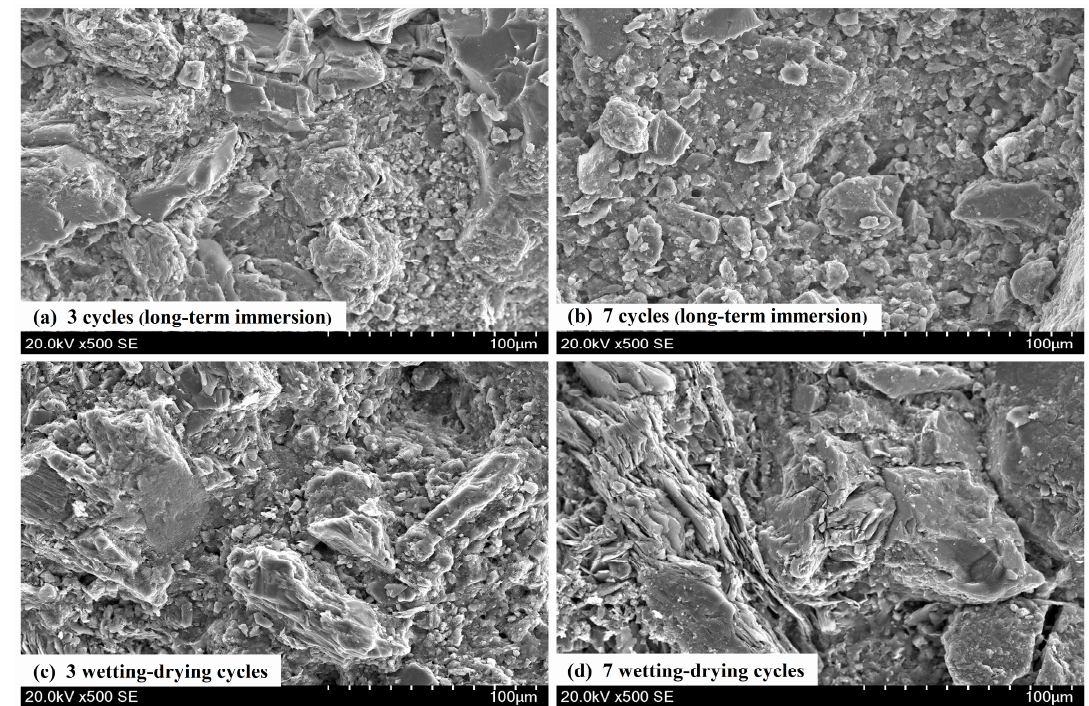
Figure 6. Scanning electron microscope (SEM) photomicrographs of sandstone samples after water–rock interactions.